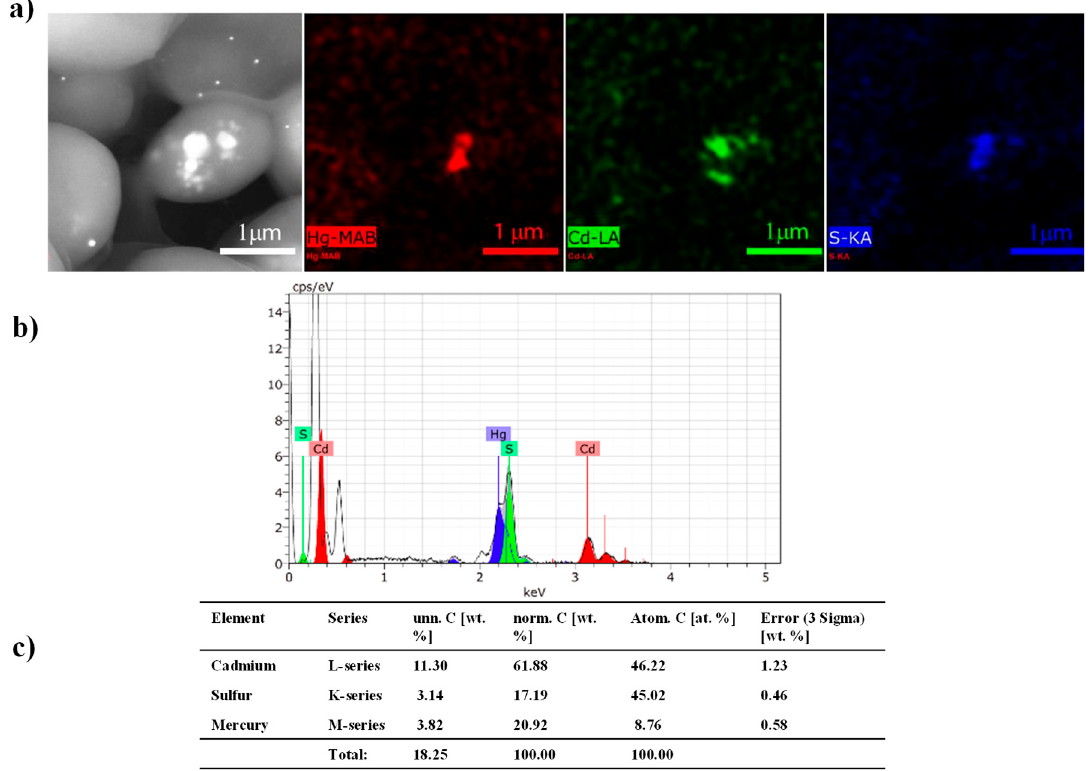
Figure 5. Formation of CdHgS nanoparticles (NPs) by Candida species in presence of the Cd–Hg mixture. ( a ) Electron image and elemental maps of Hg M α line, Cd L α line and S K α line; ( b ) qualitative analysis of the elements present in the formed compound; and ( c ) their corresponding quantification.